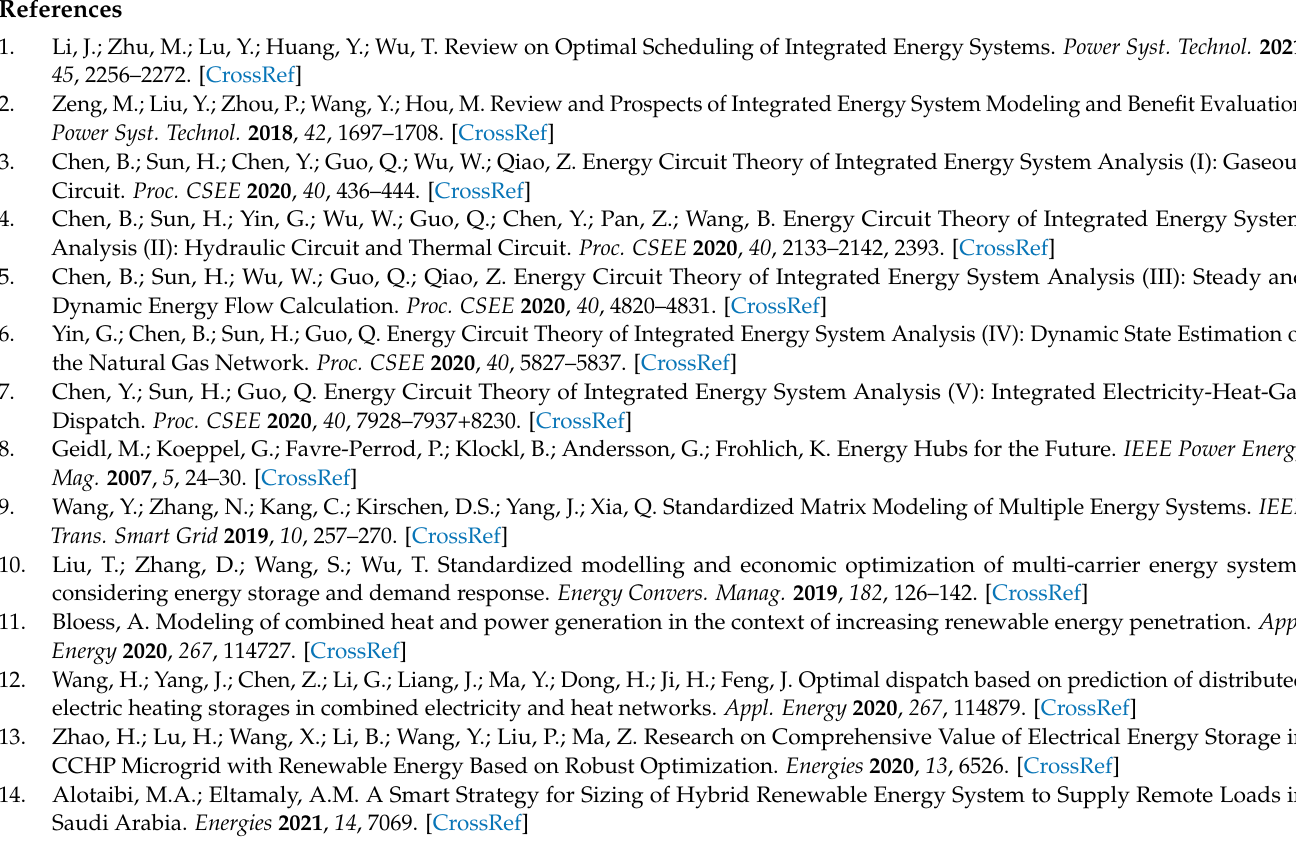
Figure A2. Renewable energy output and various load demand curves of each PIES: ( a ) PIES 1 renewable energy output and various load demand curves; ( b ) PIES 2 renewable energy output and various load demand curves; ( c ) PIES 3 renewable energy output and various load demand curves; ( d ) PIES 4 renewable energy output and various load demand curves.